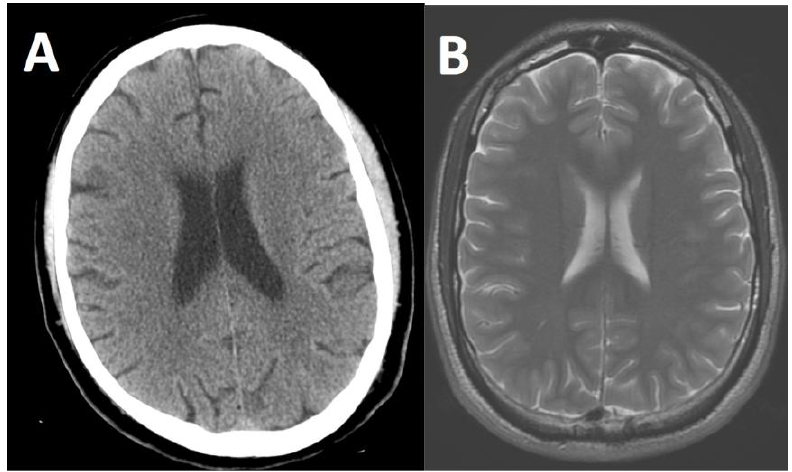
Figure 1. Images of a normal brain in the axial plane. The head computed tomography (CT) image ( A ) shows the dense skull shown as white, the brain as a mid-gray shade and the cerebrospinal fluid as dark gray. The T2-weighted magnetic resonance imaging (MRI) image ( B ) shows the skull as black, the brain as a mid-gray shade with excellent gray matter and white matter differentiation and the cerebrospinal fluid as white.